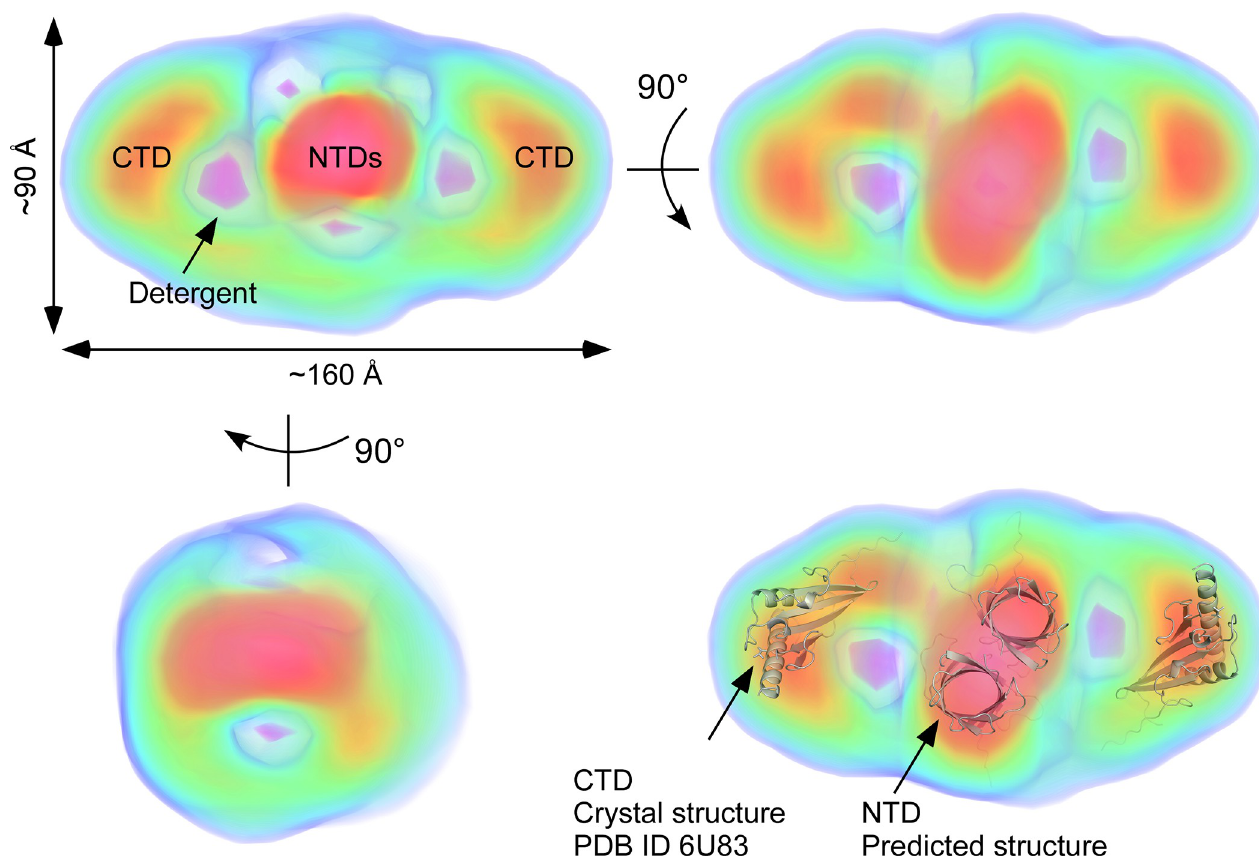
Fig 7. FopA electron density reconstructed by DENSS [43]. Maps are colored according to density (blue = 5 sigma, green = 10 sigma, yellow = 15 sigma, red = 20 sigma, magenta = -5 sigma). The high density central core likely corresponds to the dimer of the N-terminal β -barrel domains (NTDs). The negative density (pink) surrounding the dimers belongs to low-density detergent corona. The high density regions at either end possibly corresponding to the extended C-terminal domains (CTD) connected by the flexible